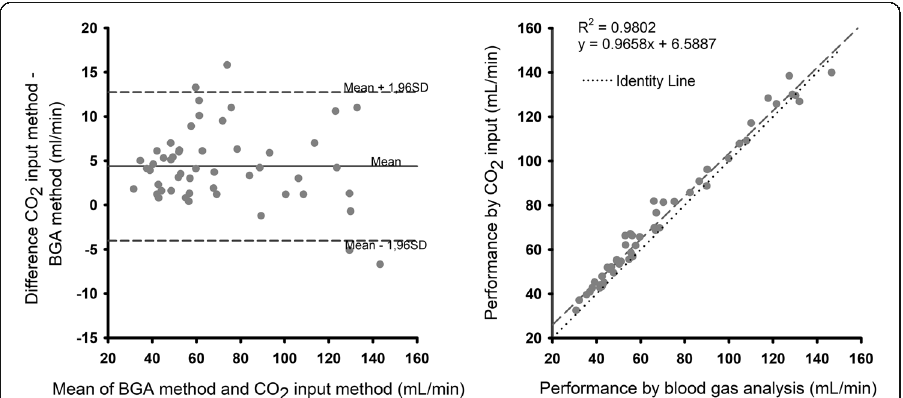
Fig. 5 Comparison of CO 2 removal performance using the infusion and blood gas analysis methods. Assessed across all tested devices and parameter settings at 37°C. a Bland – Altman analysis to demonstrate the relationship between the BGA method and the CO 2 input method. Mean = 4.2mL/min, SD = 4.4mL/min, Limits of Agreement (95%) = − 4.4mL/min, 12.9mL/min. b Linear regression analysis comparing the two test methods: BGA method and CO 2 input method. Slope not significantly different from 1.0. BGA, blood gas analysis; SD, standard